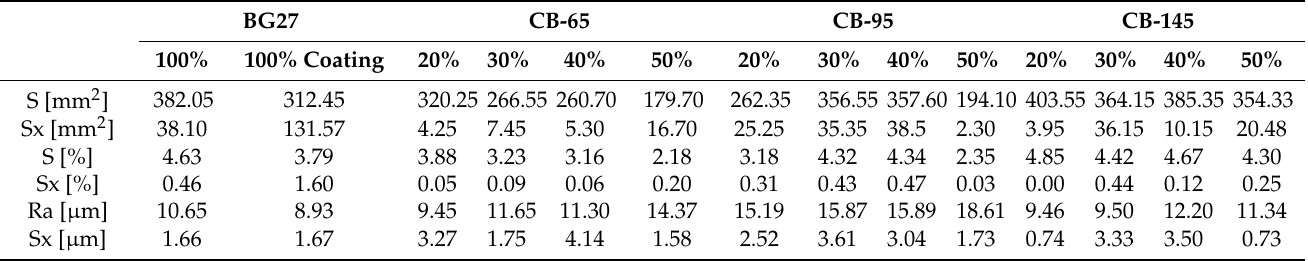
Table 5. Result of casting test—measured values of veining and roughness of the cast surface.